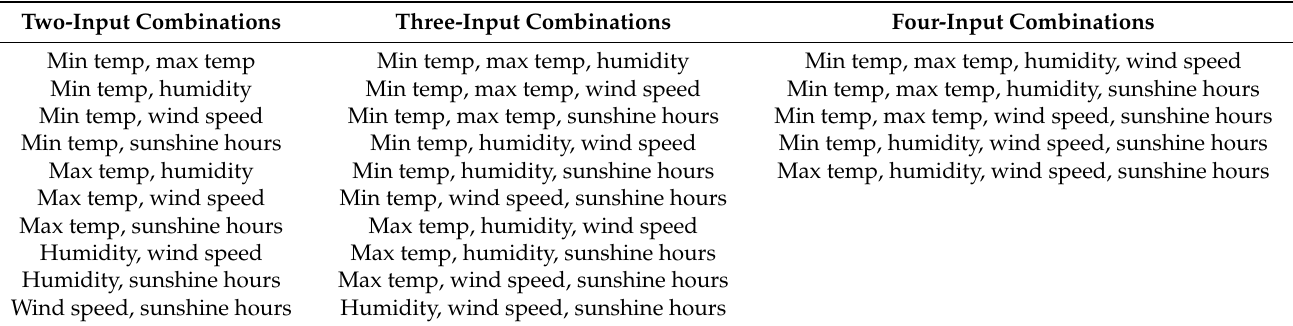
Table 4. Different combinations of two-, three-, and four-input